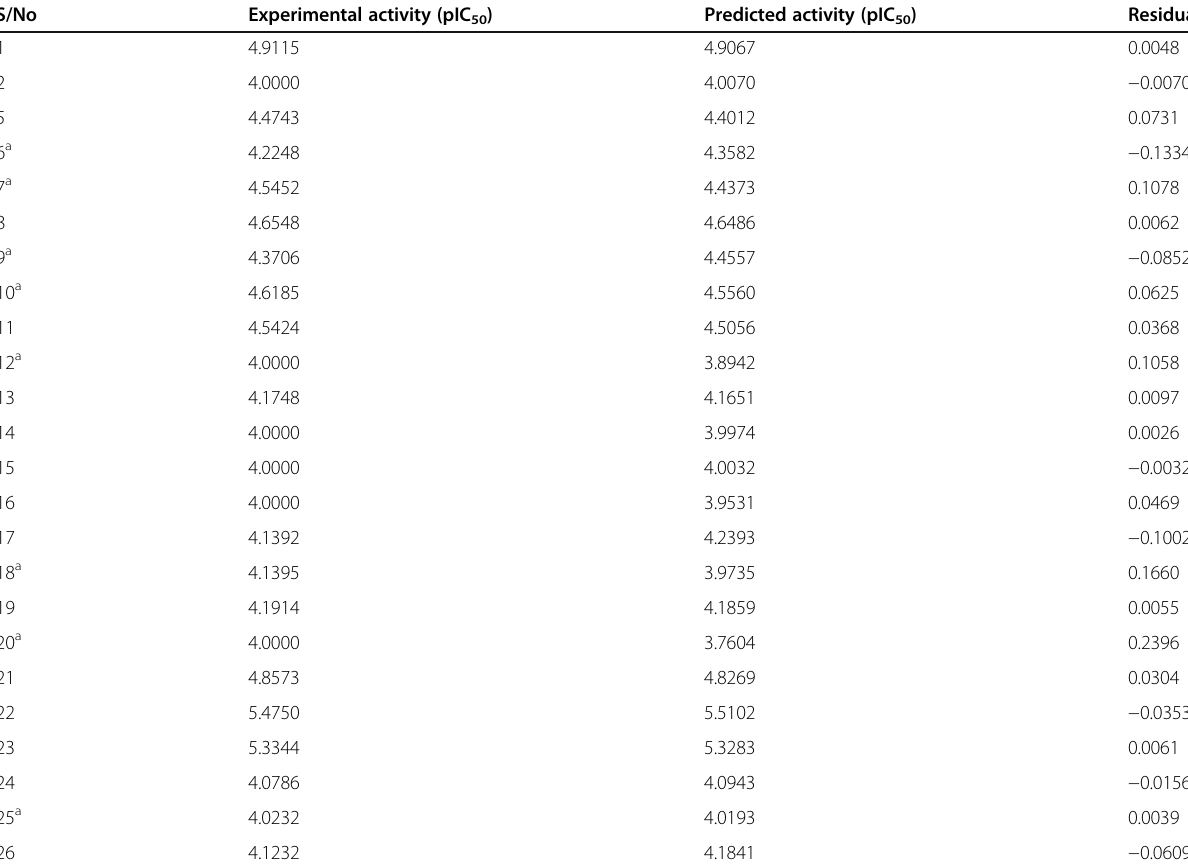
Table 4 Comparison of experimental activity (pIC 50 ), predicted activity (pIC 50 ), and residual of developed model